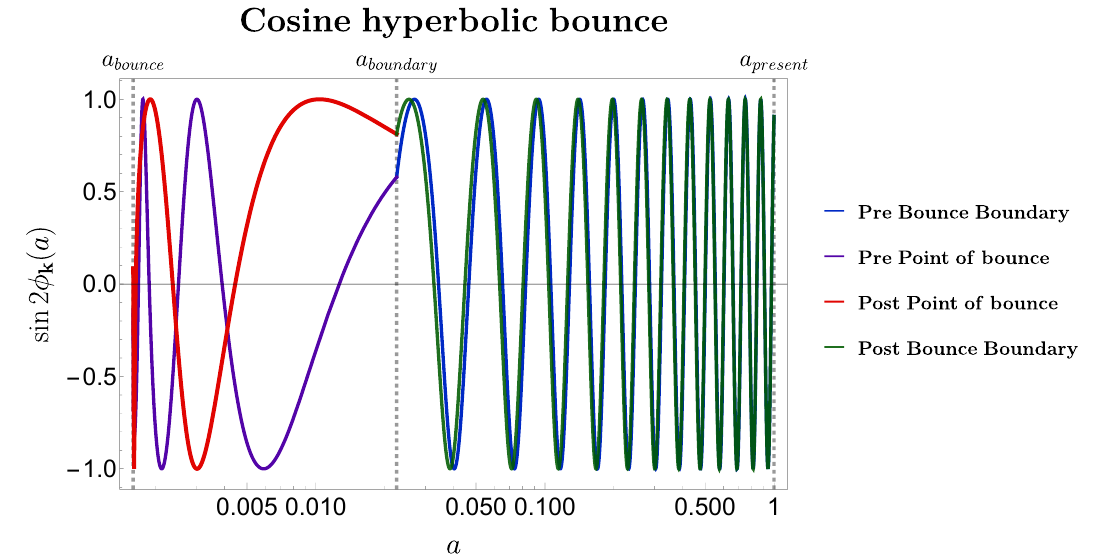
Figure 11: Sine of twice of squeezing angle at different regions plotted against scale factor.